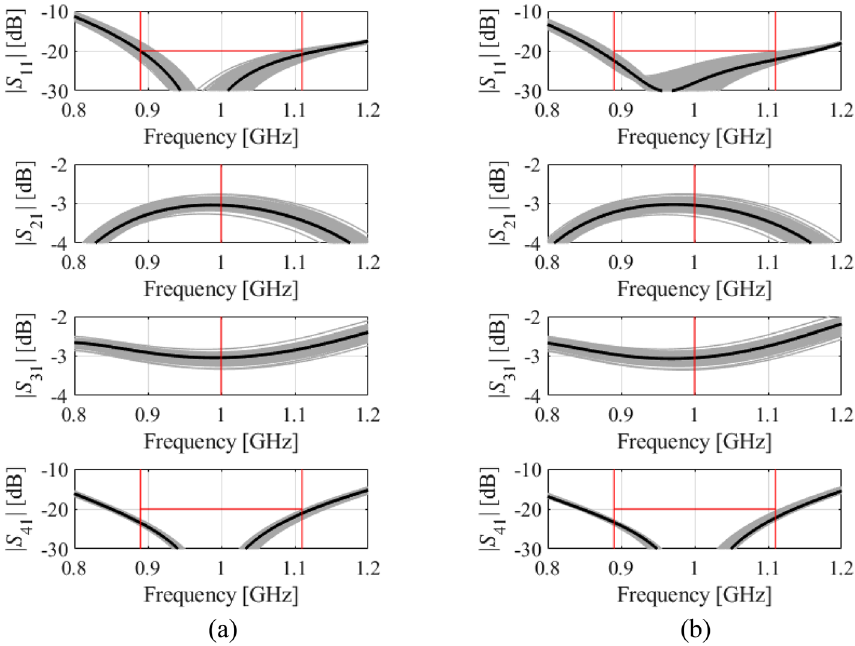
Figure 7. Visualization of EM-based Monte Carlo analysis for Circuit I: ( a ) at the nominal design, and ( b ) at the optimal design rendered with the use of the procedure introduced in this work. MC is executed using 500 random data points. Gray curves represent EM simulations, whereas the circuit characteristics at the nominal ( a ) and optimal design ( b ) are shown black.